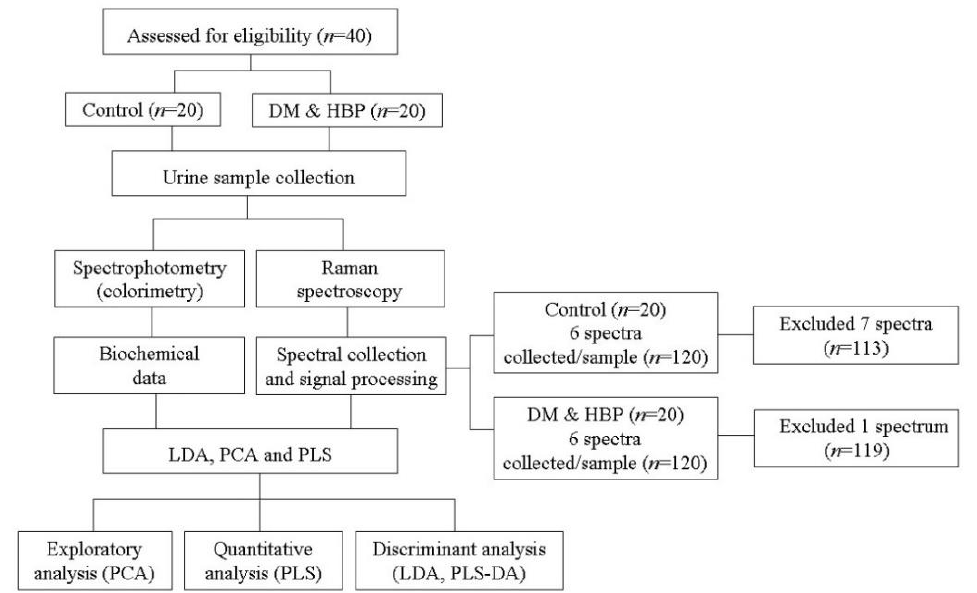
Figure 1. Diagram of the number of eligible samples assessed, the experimental setup, and data